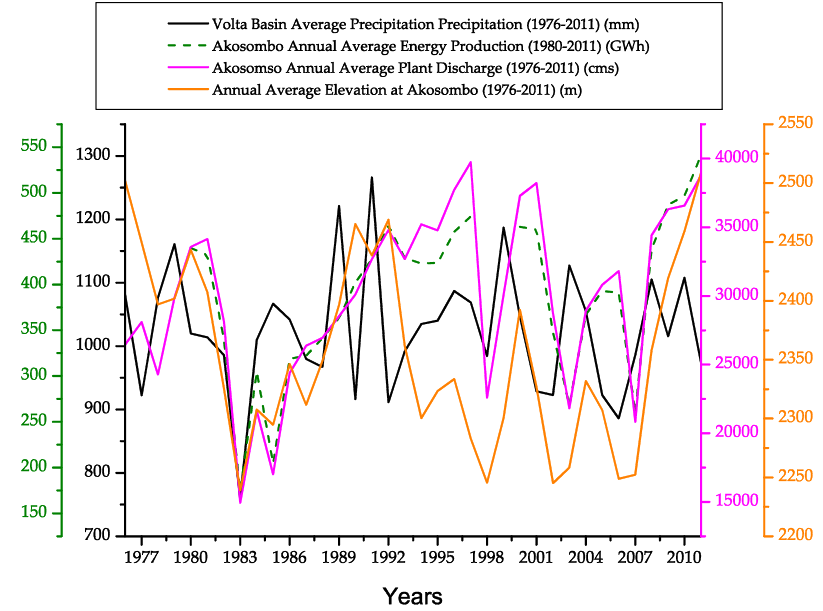
Figure 9. Plot of average precipitation, plant discharge, water level, and energy production at Akosombo dam. The average precipitation of the Volta Basin was estimated using the Thiessen